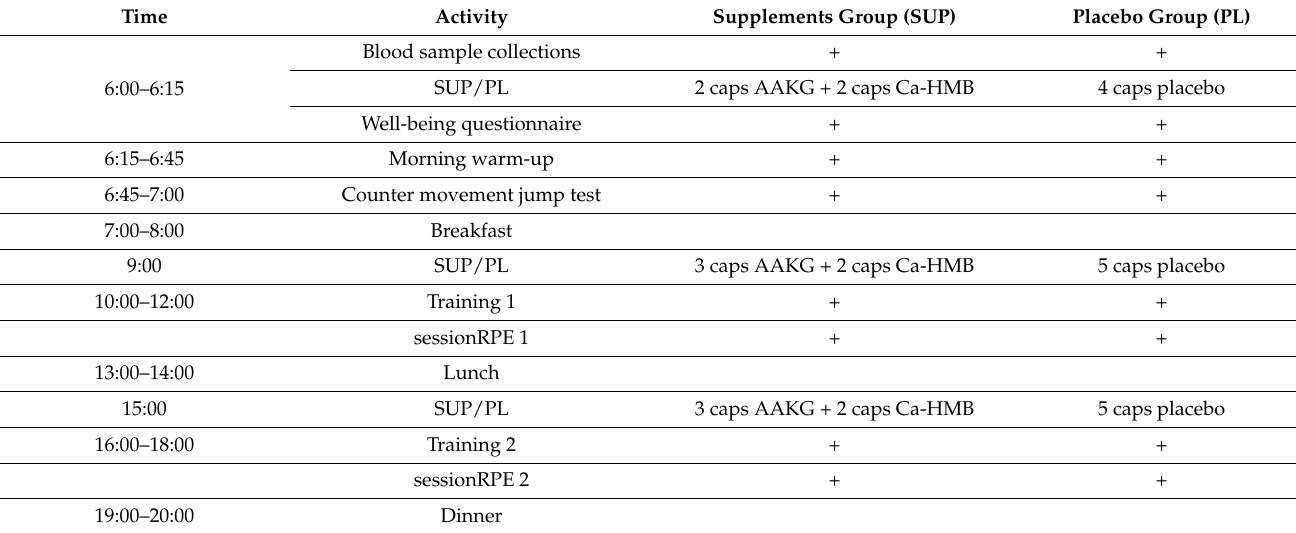
Table 2. Daily regimen during the 12-day study